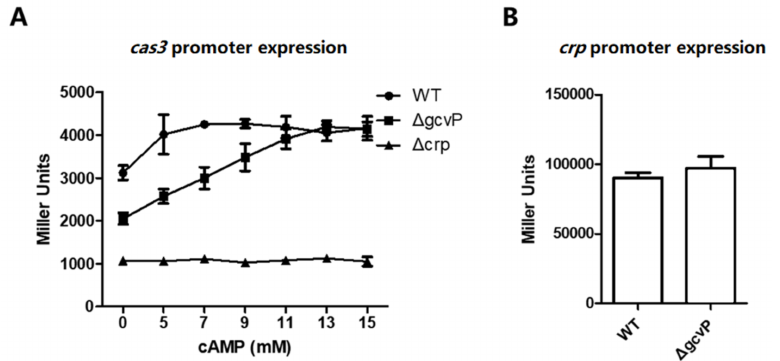
Figure 8. The su ffi cient concentration of cAMP restores cas3 promoter activity reduced by the mutation of GCS. ( A ) The β -gal activity of the cas3 promoter was measured by reporter plasmids in WT, ∆ gcvP , or ∆ crp cultured in LB media supplemented with 0, 5, 7, 9, 11, 13, or 15 mM cAMP. The addition of excess cAMP resulted in a significant increase in cas3 promoter activity in WT and ∆ gcvP . The cas3 promoter activity in both WT and ∆ gcvP reached the same level. ( B ) The β -gal activity of crp promoter was measured by reporter plasmids in WT (EC13) or ∆ gcvP (EC23). In both WT and ∆ gcvP , gene crp expression remained at the same level. All the data were mean ± SEM of at least three replicates, and the p value ( p < 0.05) was analyzed by the t -test.